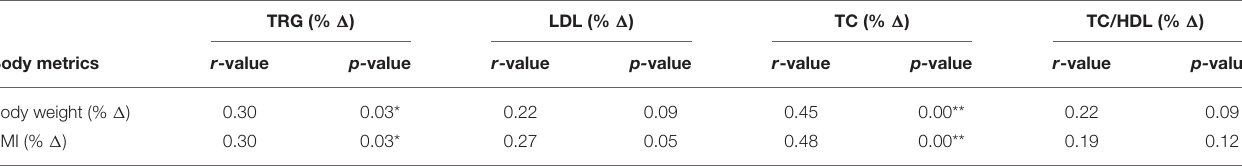
BMI, body mass index; TRG, triglycerides; LDL, low density lipoprotein; TC, total cholesterol; TC/HDL, total cholesterol/high density lipoprotein ratio. * Significantly correlated (p < 0.05). ** Significantly correlated (p < 0.01).